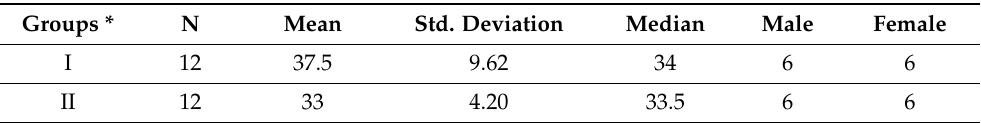
Table 1. Demographic Data.